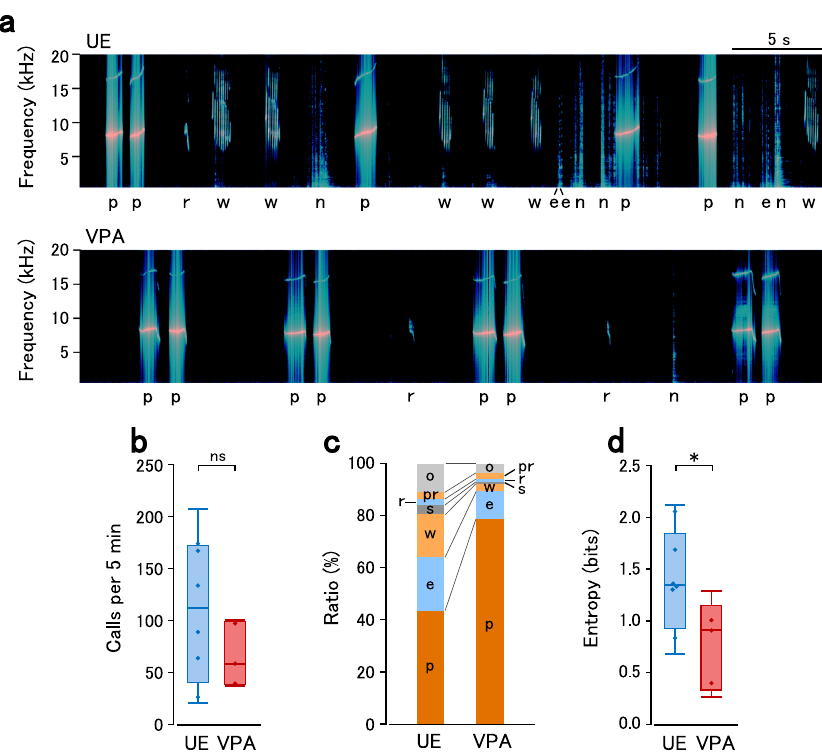
Fig. 3 Altered isolation calls in VPA-exposed marmosets. a Representative vocalization spectrogram for UE (top) and VPA (top) animals at 12 weeks of age. The type of call is shown below the spectrogram. Call types: e ekk or cough, p phee, r trill, w twitter, n indicates noise. b The average number of calls in UE and VPA animals at 11 – 13 weeks. The boxplots represent the median, quartiles, and data range. n = 8 animals (UE) and n = 5 animals (VPA). Two-sided t -test, p = 0.16. ns, not signi fi cant. c Average ratio of call types in UE and VPA animals. Call types: pr phee-trill or trill-phee, s tsik, o others. Other annotations are as in ( a ). d The average entropy of calls in UE and VPA animals. The boxplots represent the median, quartiles, and data range. Two-sided t -test, p = 0.036. * p <